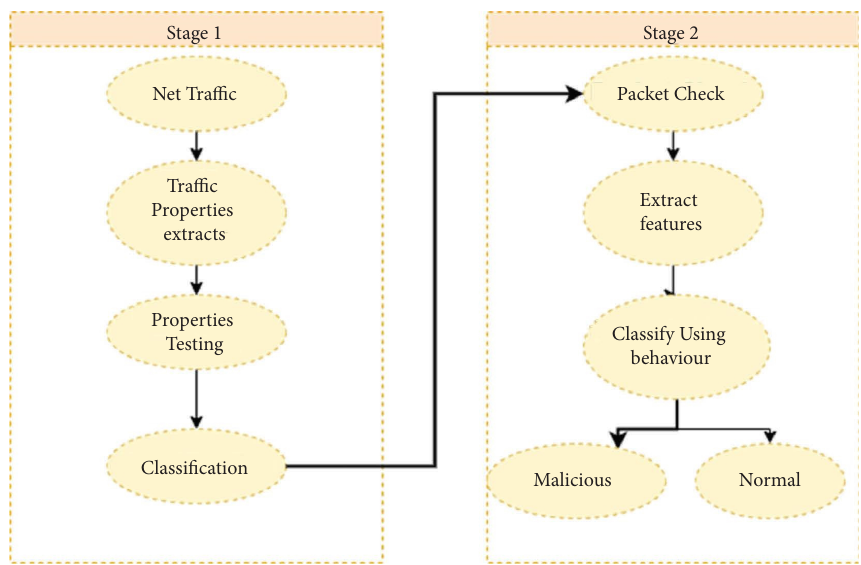
Figure 2: Te proposed model architecture. Table 1: Properties used to detect